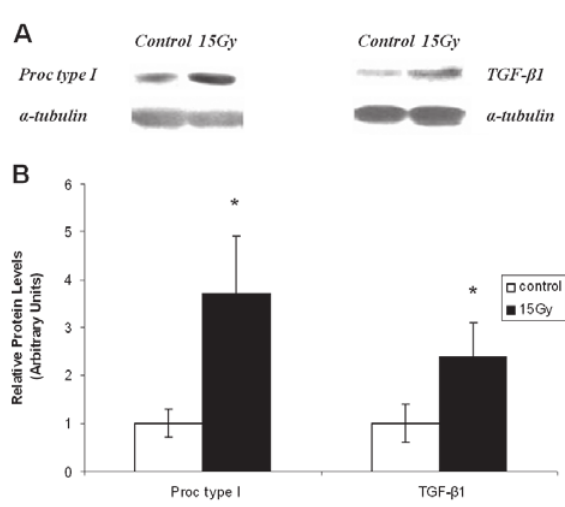
Fig. 1 - Difference in expression of the proc type I and TGF-β1 proteins in the LV. Panel A, representative Western blotting. of proc type I and TGF-β1. Panel B, densitometric analyses of the proc type I and TGF-β1 blots. White bars represent control and black bars represent irradiated group. * p < 0.05.